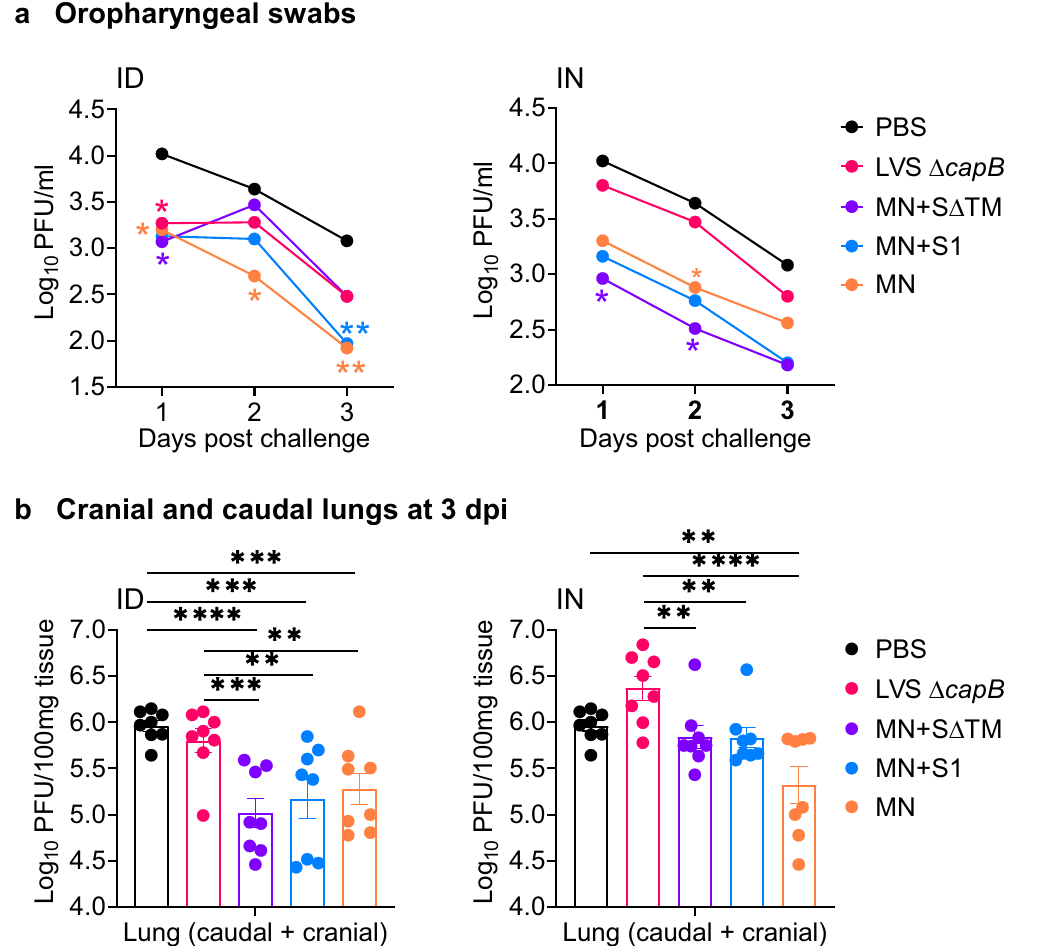
Fig. 6 Viral load in oropharyngeal swabs and cranial and caudal lungs 3 days post challenge. Hamsters were immunized ID or IN as described in Fig. 2. a Oropharyngeal swabs were collected at 1, 2, and 3 days post challenge and assayed for viral load by plaque assay. Data are mean Log 10 PFU per ml. The standard errors were omitted in the graphs for clarity. * P < 0.05; ** P < 0.01 (color coded to each vaccine) vs. Sham (PBS) by repeated measure analysis of variance. b Cranial and caudal lung homogenates were prepared at 3 days post challenge and assayed for viral titer. Data are mean ± SE of PFU per 100 mg of homogenized tissue, as indicated. Each symbol represents one animal. ** P < 0.01; *** P < 0.001; **** P < 0.0001 by two-way ANOVA with Dunnett multiple comparisons (GraphPad Prism